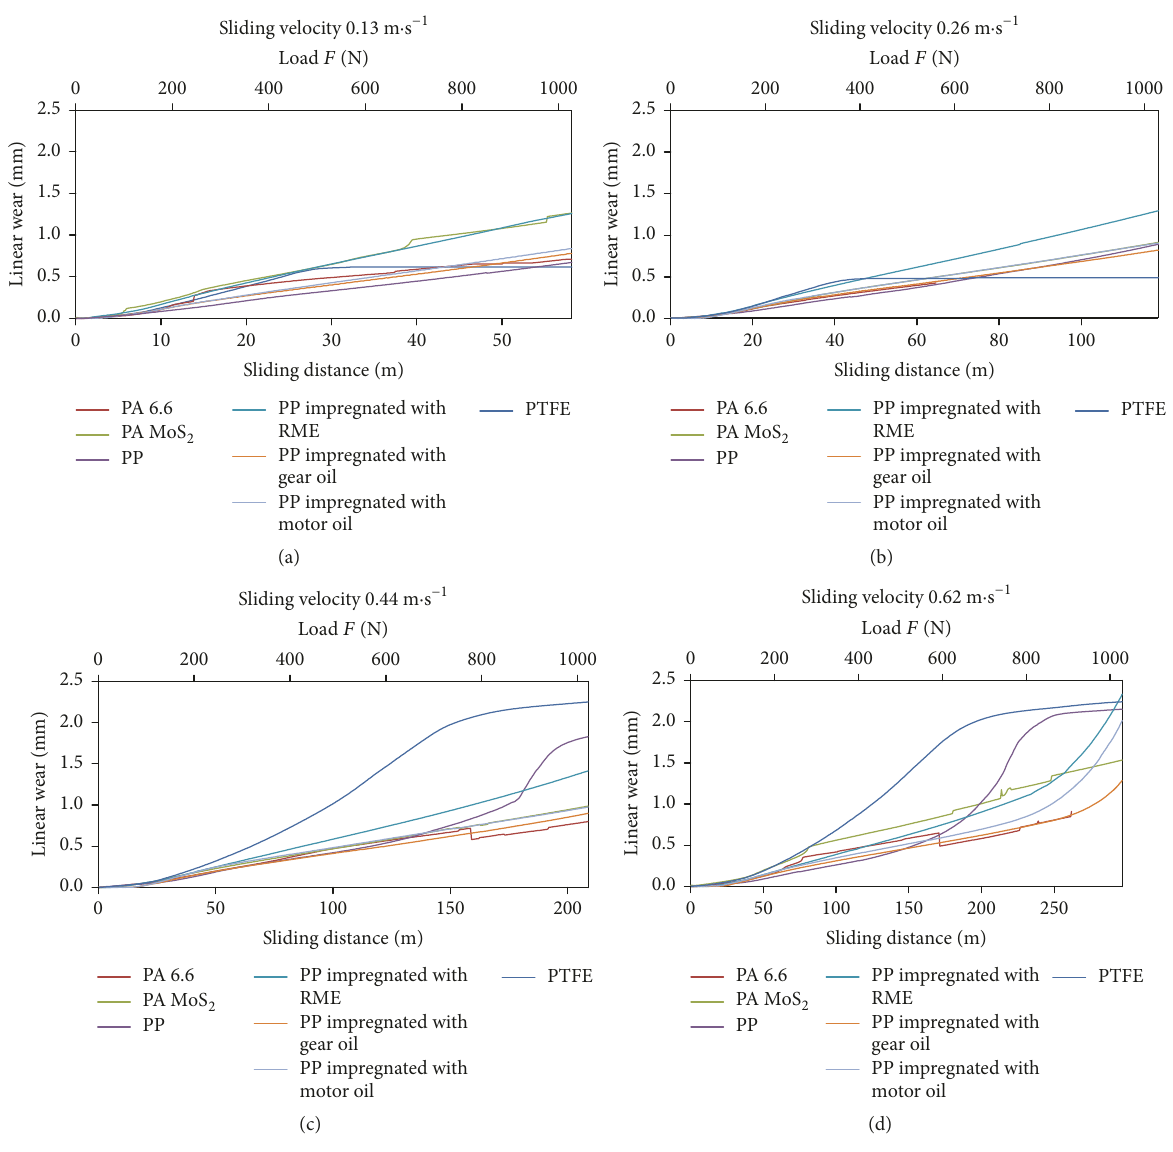
Figure 5: Relationship between sliding distance, load, and linear wear of the specimens under various sliding velocities: (a) 0.13, (b) 0.26, (c) 0.44, and (d) 0.62 m ⋅ s −1